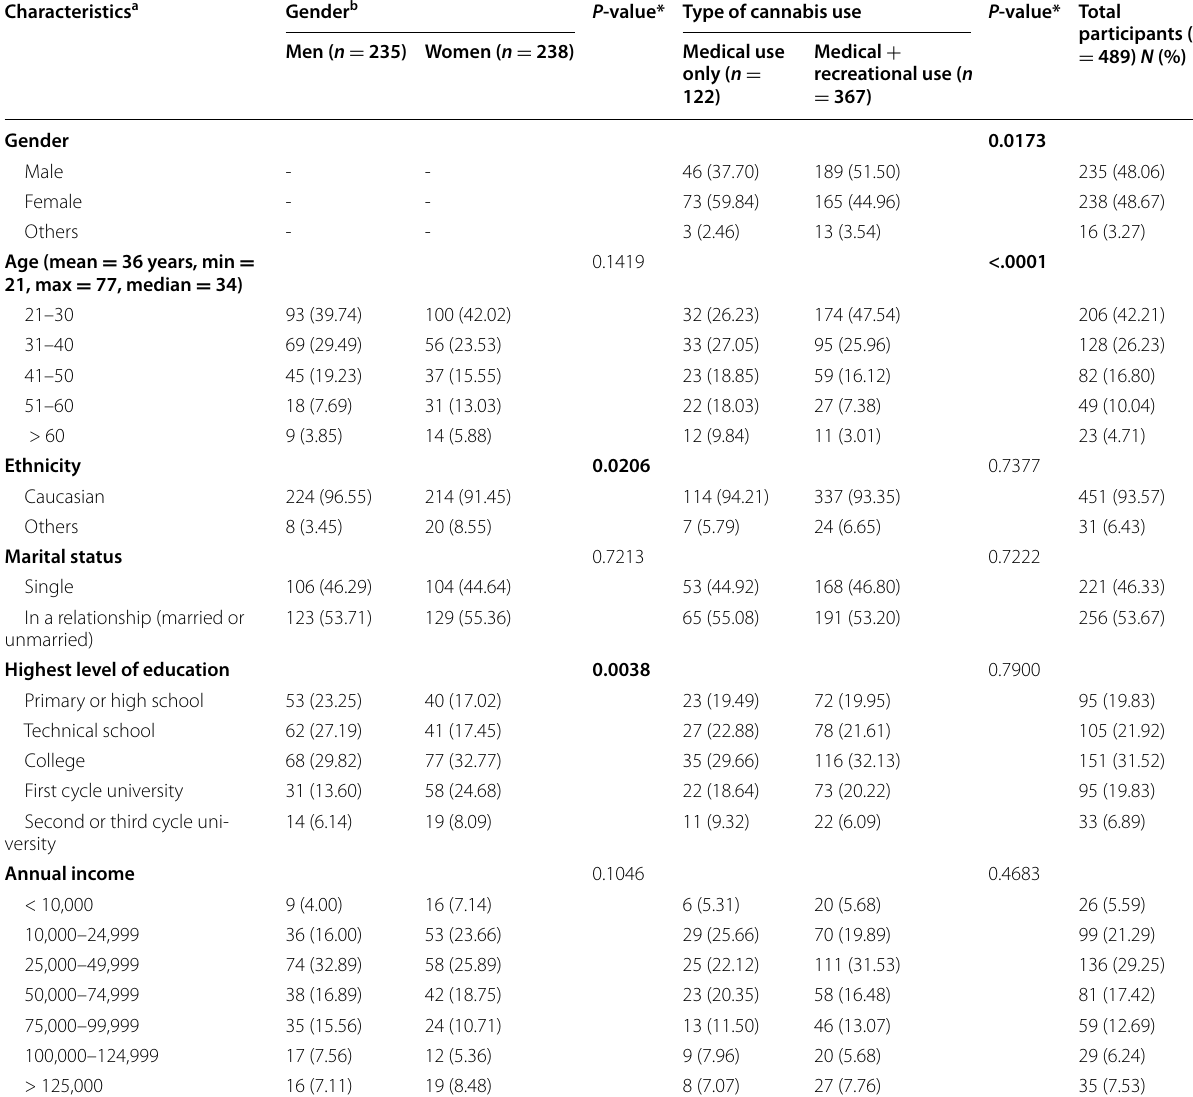
Table 1 Characteristics of participants who reported self‑medication with cannabis based on an online survey in Quebec